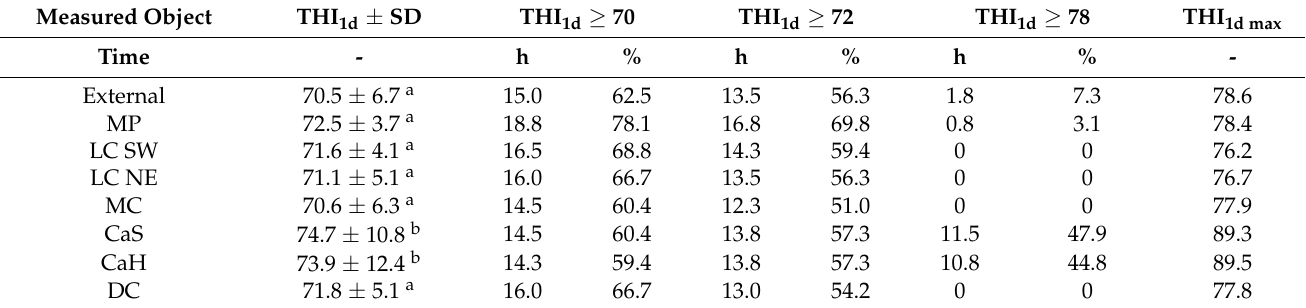
Table 3. Results of measurements and statistical comparison of THI values of the external thermal– humidity environment of outdoor air and all studied housing objects during the hot summer day. Different superscript letters ( a,b ) are a sign of a significant difference ( ANOVA ; Tukey’s HSD test ; p ≤ 0.05) between calculated THI 1d values of measured objects. Identical superscript letters for numbers in a column indicate that there is no statistically significant difference between measured values in compared